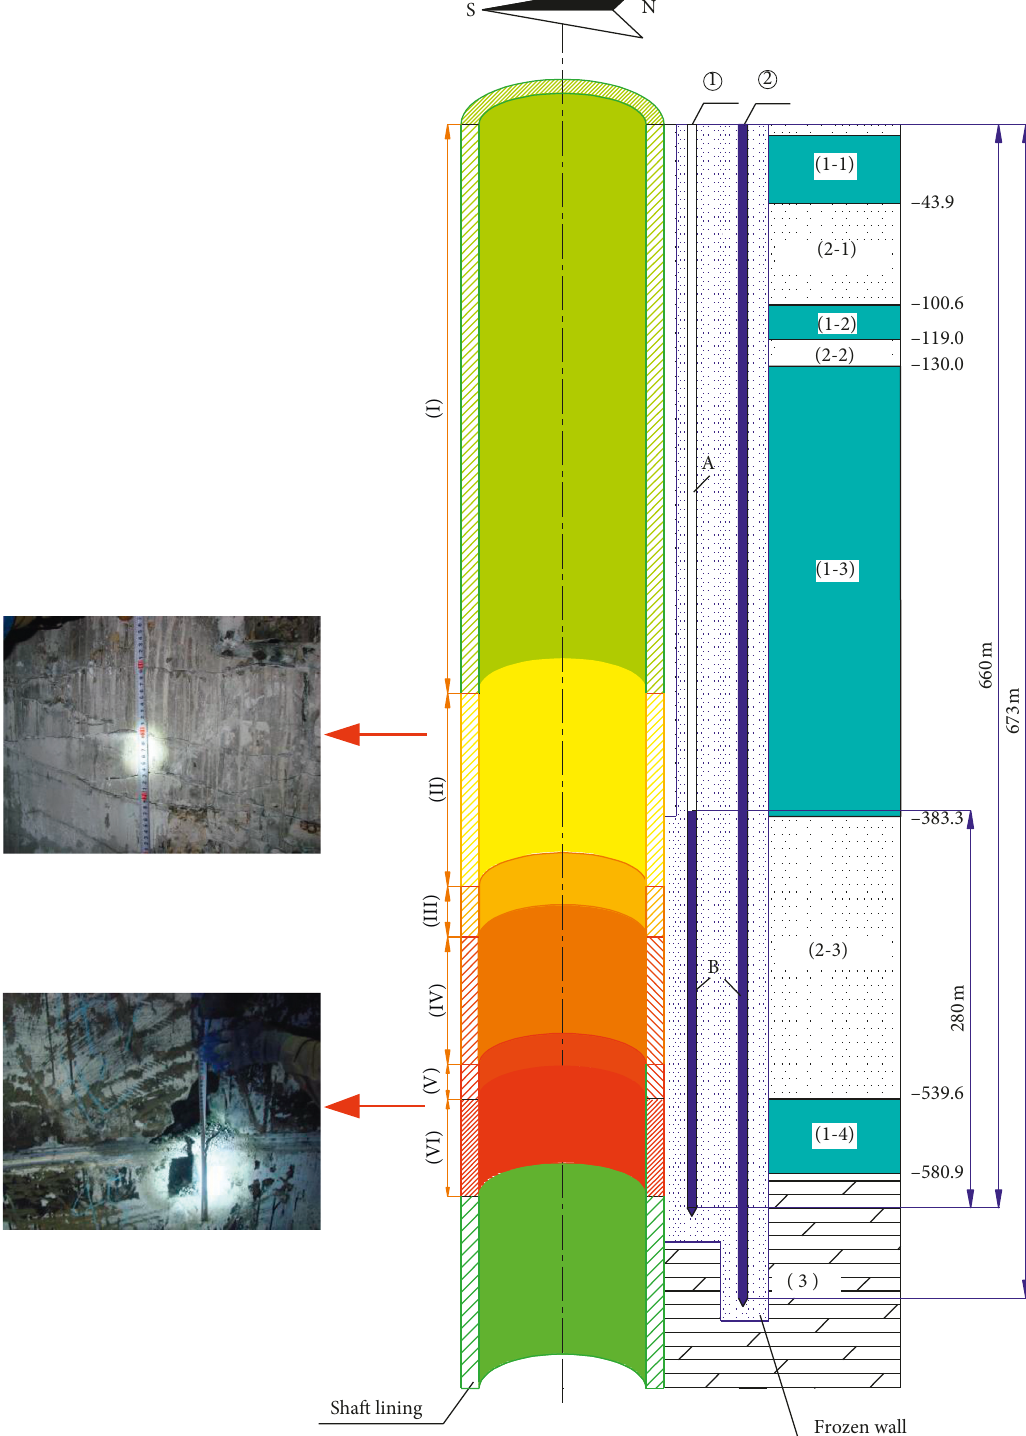
Figure 1: Schematic diagram of stratigraphic distribution and shaft lining